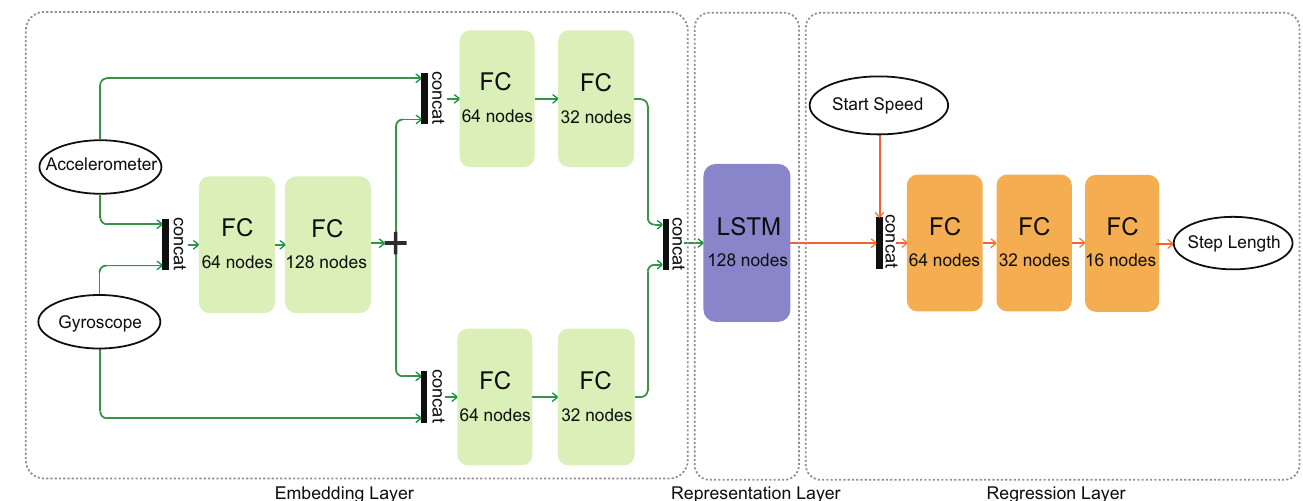
Figure 4. LSTM-based dead-reckoning model structure. Its inputs include acceleration readings, gyroscope readings, and start speed at this step. Our model consists of three modules: the embedding layer, the representation layer, and the regression